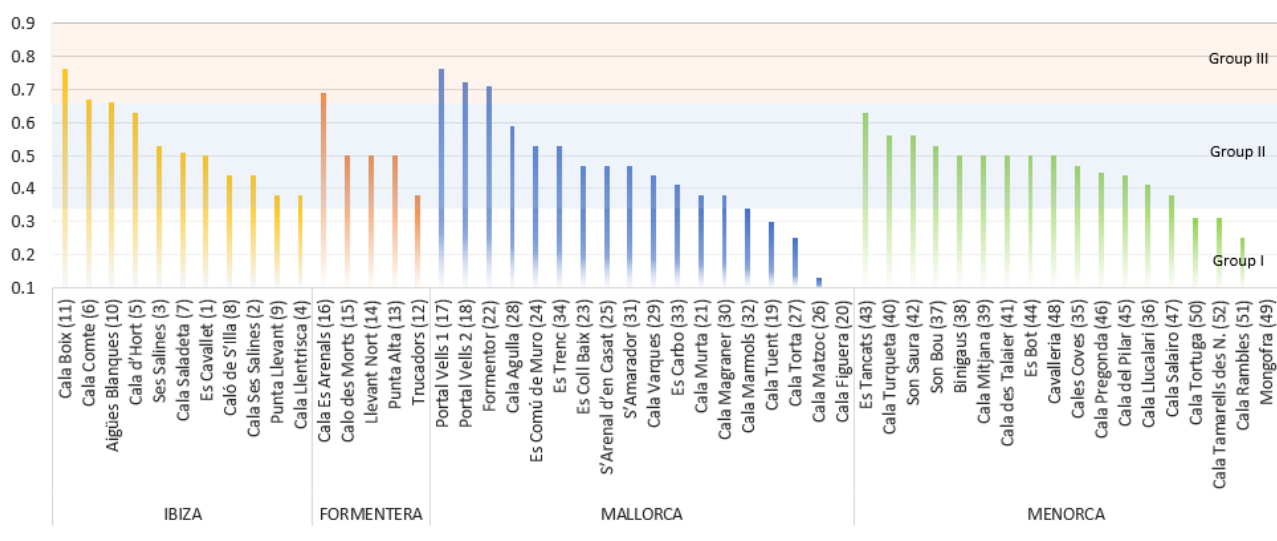
Figure 12. HSI value obtained at the 52 Balearic sites (CSSI method).